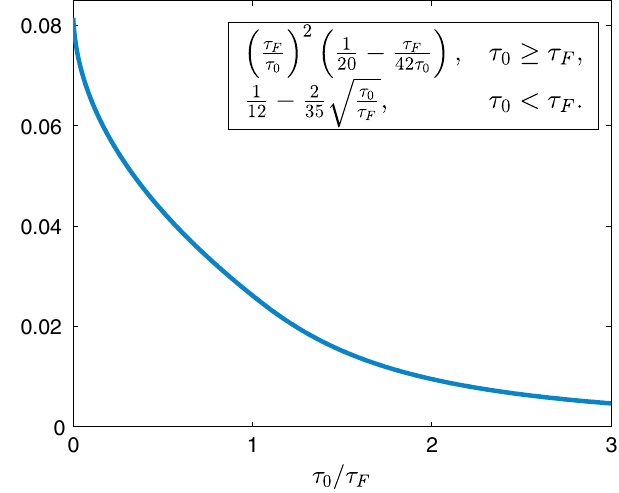
FIG. 5. A convex function that appears in Eq.